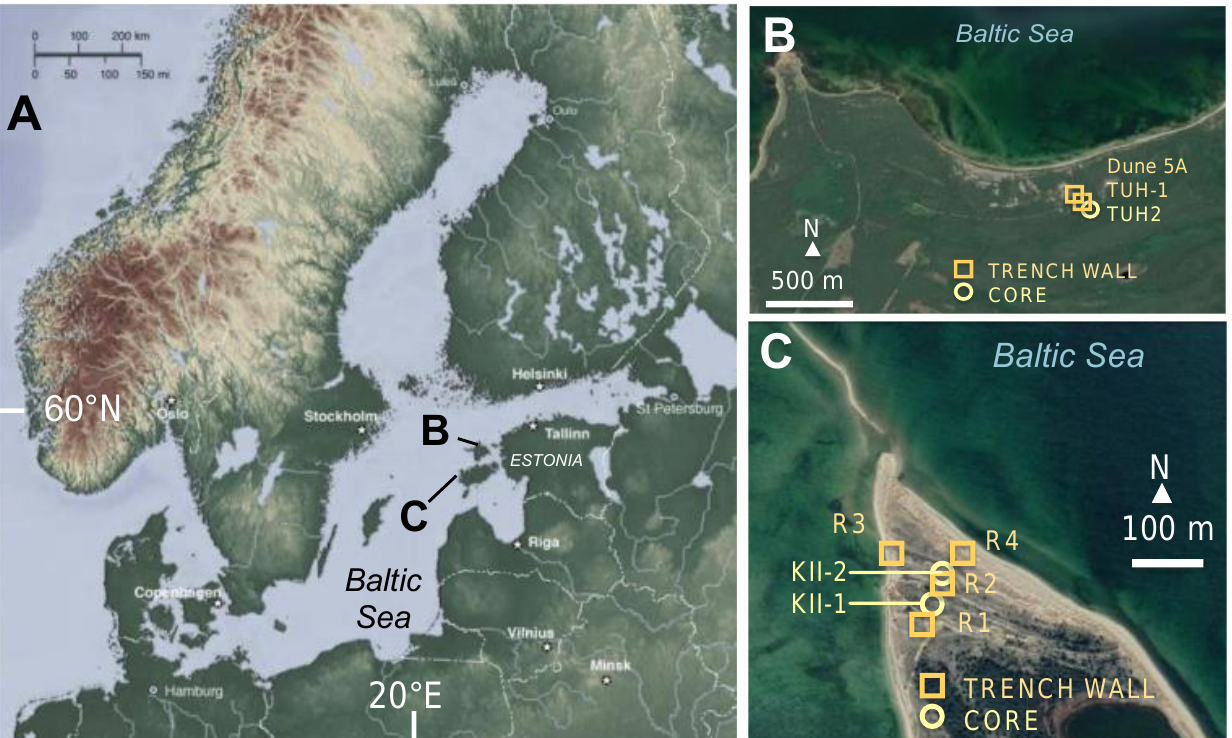
Figure 1. ( A ) Location of Hiiumaa ( B ) and Saaremaa ( C ) Islands along the east coast of the Baltic Sea. ( B ) Tahkuna strandplain, northern Hiiumaa Island, with locations of a beach ridge trench (Site TUH-1; see Figure 2A), nearby core sample (TUH-2), and a deep trench through a large parabolic dune (Site 5A; Figure 2B). ( C ) Harilaid strandplain, northwest Saaremaa Island, showing locations of the four trenched ridge generations (trenches R1-4). Cores KII-1 and KII-2 (see Figure 2C) were taken through ridges R1 and R2 (Figure 2D), respectively, with a coastal exposure measured for ridge R3 (see Figure 2E; GoogleEarth TM database).